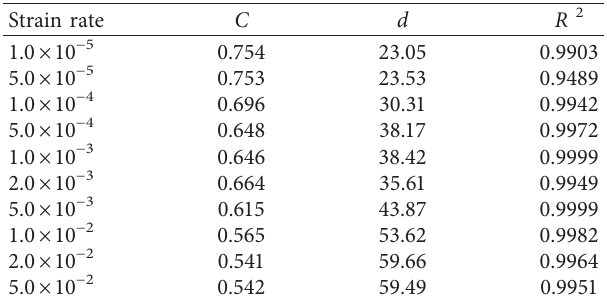
Figure 12: Relationship between concrete cube length and compressive strength. (a) 1.0 × 10 − 5 /s ∼ 1.0 × 10 − 3 . (b) 2.0 × 10 − 3 ∼ 5.0 × 10 − 2 . Table 3: Size effect law parameters of NPCC under different loading strain